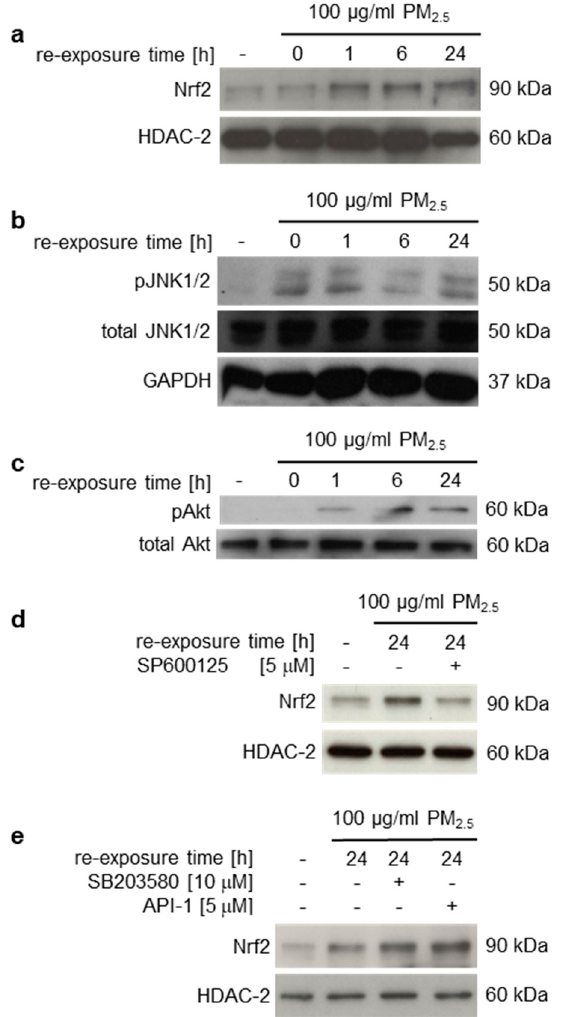
Figure 2. Long-term exposure to PM 2.5 induces nuclear translocation of Nrf2, which is regulated by JNK1/2. BEAS-2B cells were cultured in the presence of 100 µg/mL PM 2.5 for 3 to 5 weeks, before final passage and re-exposure of cells to 100 µg/mL PM 2.5 for the indicated time points (0–24 h). The JNK1/2 inhibitor SP600125 (5 µM), the p38 inhibitor SB203580 (10 µM) or the Akt inhibitor API-2 (5 µM) were added 1 h prior to the last PM 2.5 re-exposure. ( a , d , e ) Translocated Nrf2 was detected in nuclear extracts by immunoblotting and normalized to histone deacetylase (HDAC)-2. ( b , c ) Phosphorylated JNK1/2 (pJNK1/2) and Akt (pAkt) were immunodetected in non-fractionated cell lysates and normalized to total amounts of JNK1/2, Akt, or GAPDH. Cells, cultured in the absence of PM 2.5 , served as controls (first lane). Inhibition of JNK1/2 decreased nuclear translocation of Nrf2. Representative blots of three different experiments are shown, except of ( e ) (n = 2).